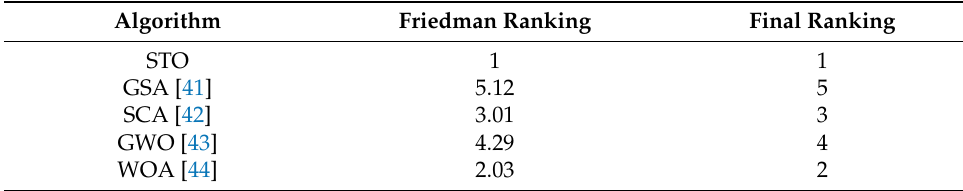
Table 7. Friedman ranking of different algorithms for all